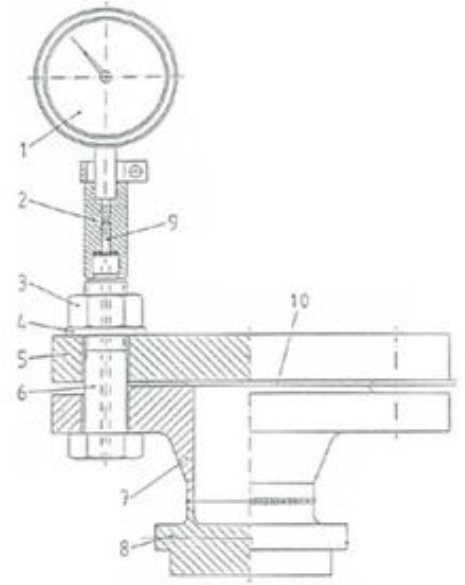
Figure 16: Micrometric system to measure the elongation of bolts